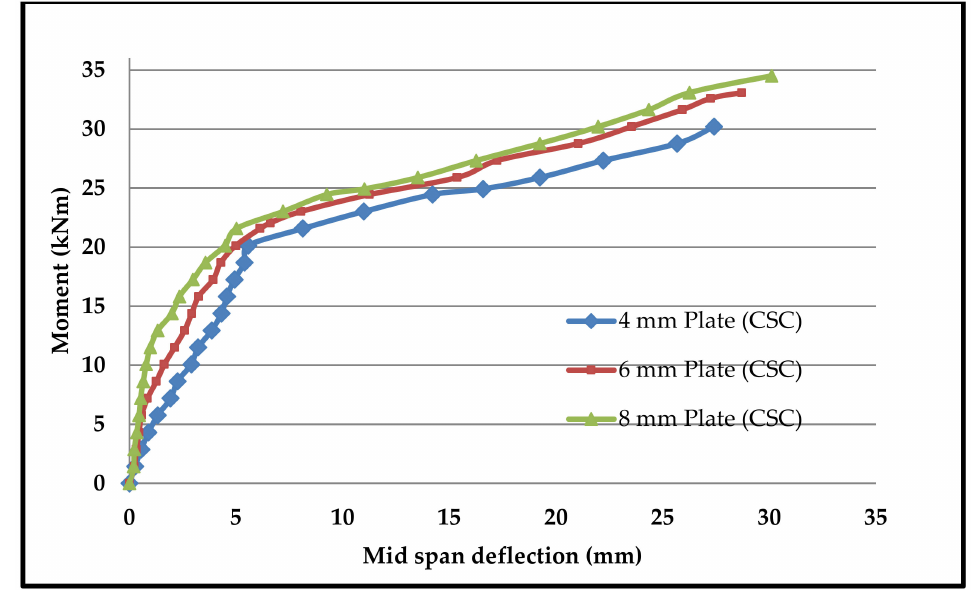
Figure 17. Moment–deflection curve for SCS beams used with CSC